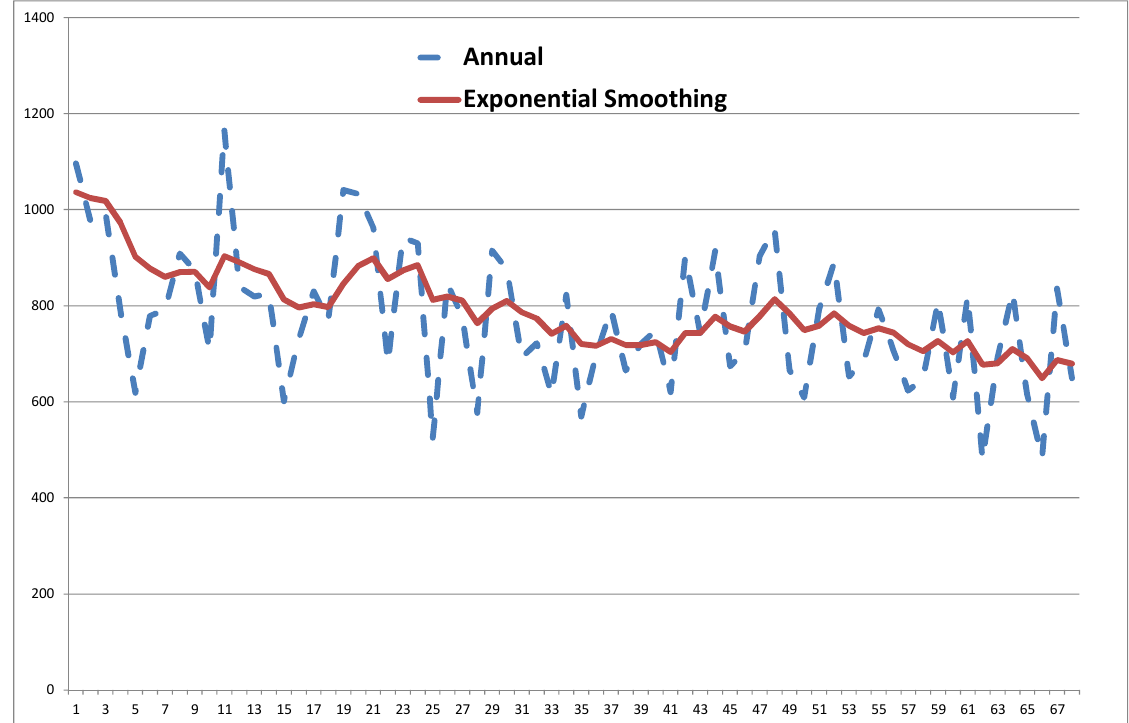
Figure 1. Annual rainfall totals for Perth Airport from 1944 to 2011 with smoothed